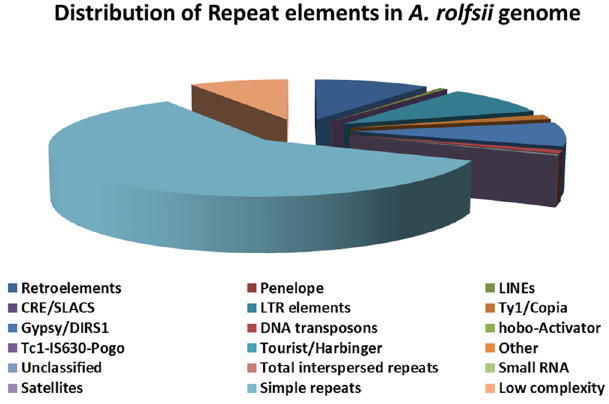
Figure 4. Pie chart of repeats in A. rolfsii